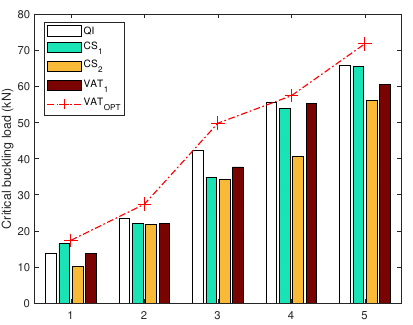
Figure 8. Comparison of different layup designs with the optimum outcome.